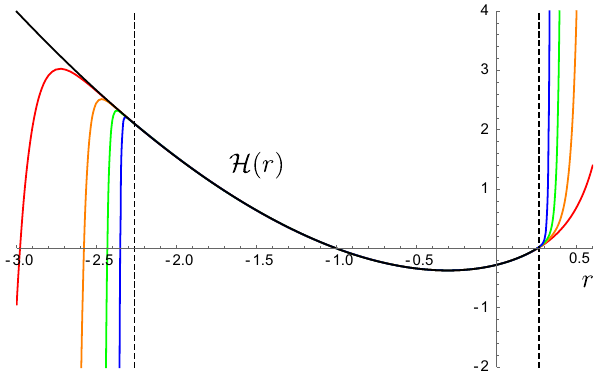
to be approaching geometric series for large values of i , which can be used to estimate the interval of convergence, denoted by the vertical dashed lines. The horizon at r = − 1 separates a static, outer region